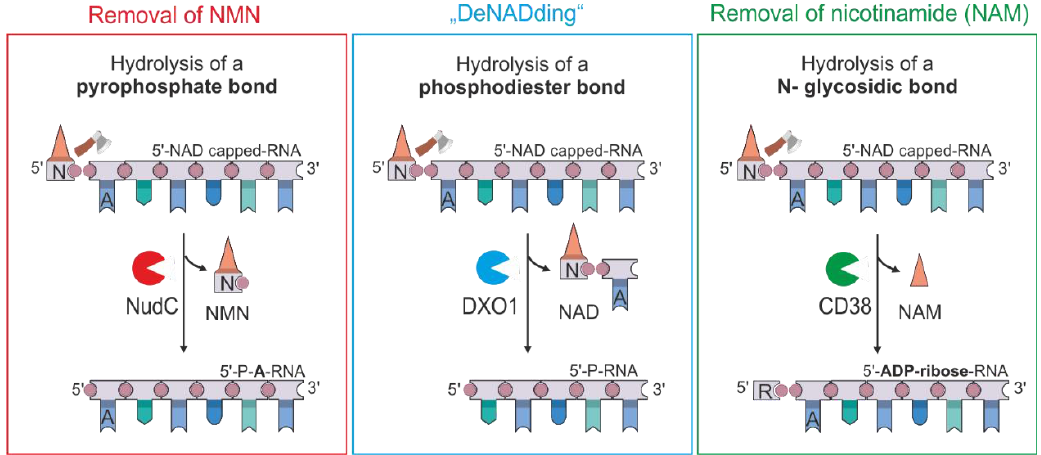
Figure 6. Decapping of NAD-RNAs by different mechanisms. Mechanism I: Hydrolysis of the pyrophosphate bond of NAD by Nudix hydrolases such as NudC or BsRppH. NAD-RNA is processed to 5’-monophosphorylated RNA, which contains the adenosine of NAD as the first nucleotide (5’-P-A-RNA) and NMN. Mechanism II: “DeNADding”—Removal of the NAD-cap by DXO1. The phosphodiester bond between NAD and the second nucleotide is hydrolysed, which releases NAD and shortened 5’-monophosporylated RNA. Mechanism III: Removal of nicotinamide by hydrolysis of the N-glyosidic bond: CD38 catalyses the removal of nicotinamide (NAM), thereby converting NAD-RNA into ADPR-RNA.